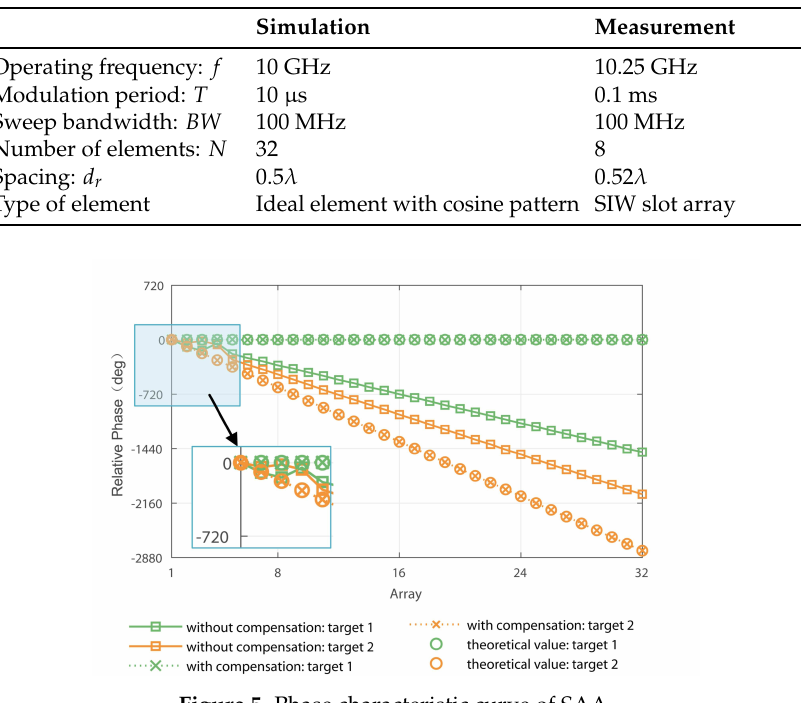
Figure 5. Phase characteristic curve of